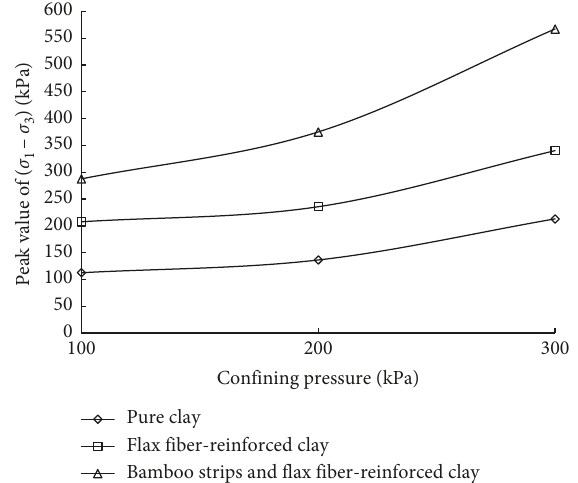
Figure 8: Peak value of ( σ